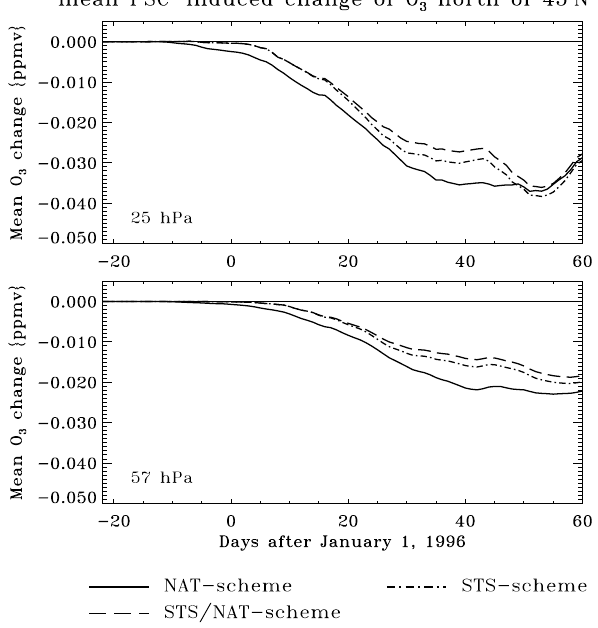
Fig. 9. Temporal change of the PSC-induced depletion of the ozone mixing ratio (ppmv) averaged over the area north of 45 ◦ N on the model levels (bottom frame) 57 hPa and (top frame) 25 hPa. Re- sults are presented for the time period between 10 December 1995, and 29 February 1996, calculated from the differences between the model experiments performed with the NAT-, the STS- and the STS/NAT-scheme, respectively, and the simulation where only liq- uid binary sulfate aerosols are considered